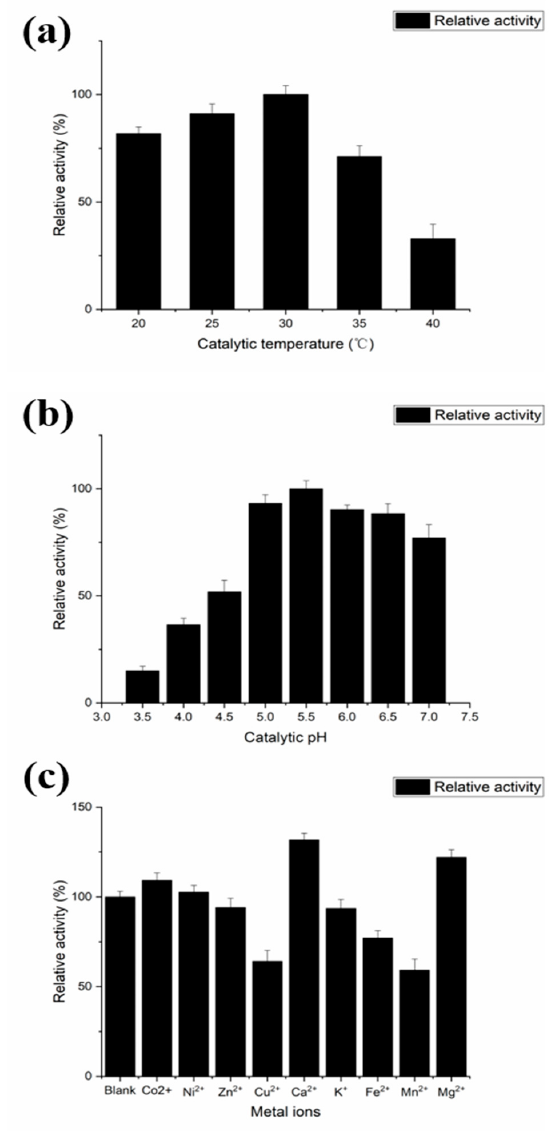
Figure 5. Characterization of the recombinant PLD PMF . ( a ) The e ff ect of the catalytic temperature. ( b ) The e ff ect of the catalytic pH. ( c ) The e ff ect of the addition of metal